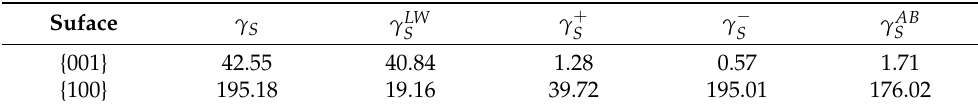
Table 4. Surface free energy and its components of the common exposed surfaces of molybdenite (mJ/m 2 ).